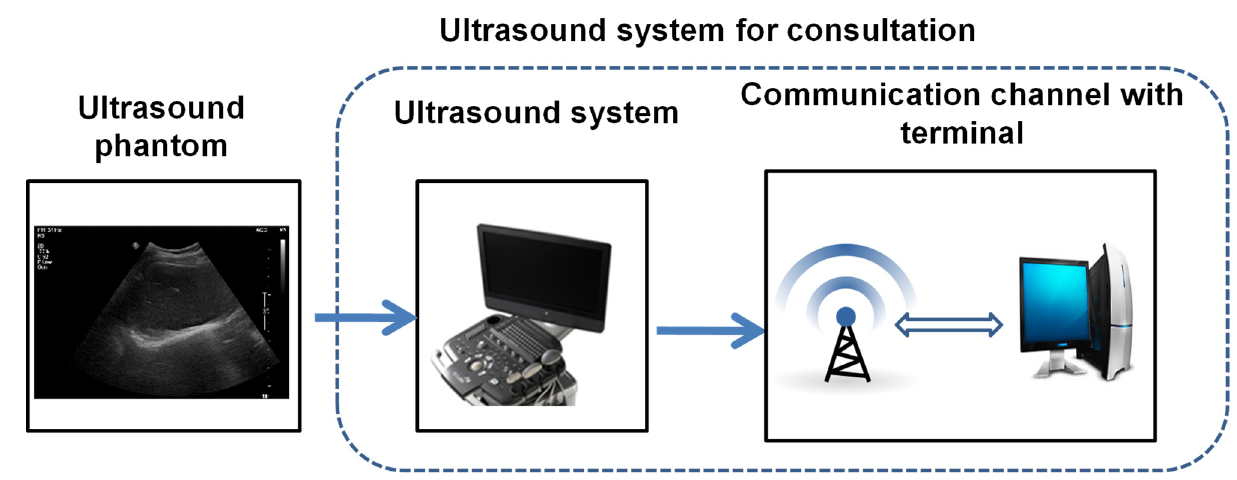
Figure 1. Our proposed concept of an ultrasound system for